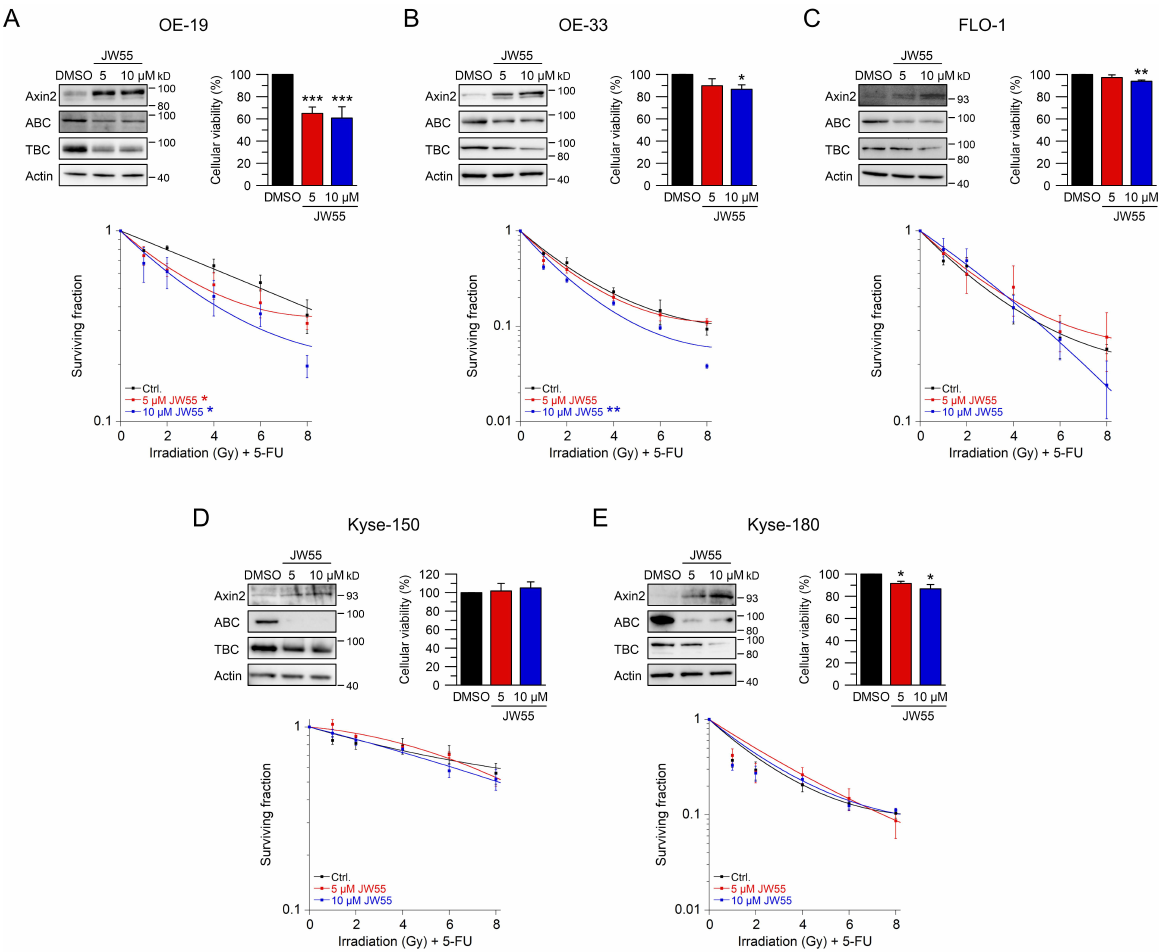
Figure 5. Inhibition of Wnt/ β -catenin signaling by the tankyrase inhibitor JW55. ( A – E ) Cell lines were left untreated (DMSO), or treated with two different concentrations of the tankyrase inhibitor JW55. Cell lines (( A )—OE-19, ( B )—OE-33, ( C )—FLO-1, ( D )—Kyse-150, ( E )—Kyse-180) were first subjected to Western blot analysis (upper left), or cellular viability assays (upper right), or were monitored for CFA survival after CRT (lower graphs). Data presented as mean ± s.e.m. from at least n = 3 independent biological replicates. * p < 0.05, ** p < 0.01, *** p < 0.001, two-way analysis of variance (ANOVA). For p -values see Table